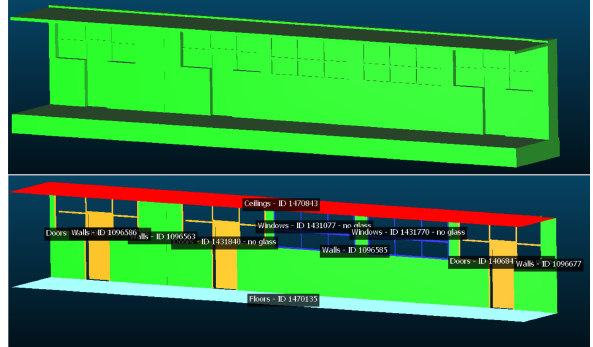
Figure 2. Model of corridor 3 in CloudCompare. Top: all object surfaces as one ‘.obj’ mesh. Bottom: relevant (parts of) surfaces in room ‘corridor 3’ as separate ‘.obj’ meshes, one per BIM object per room